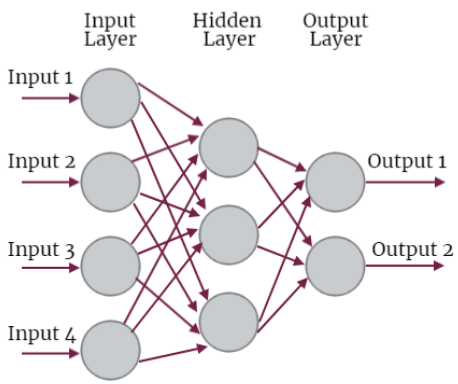
Figure 4. A generalized illustration of a simple three-layered feed-forward artificial neural network.